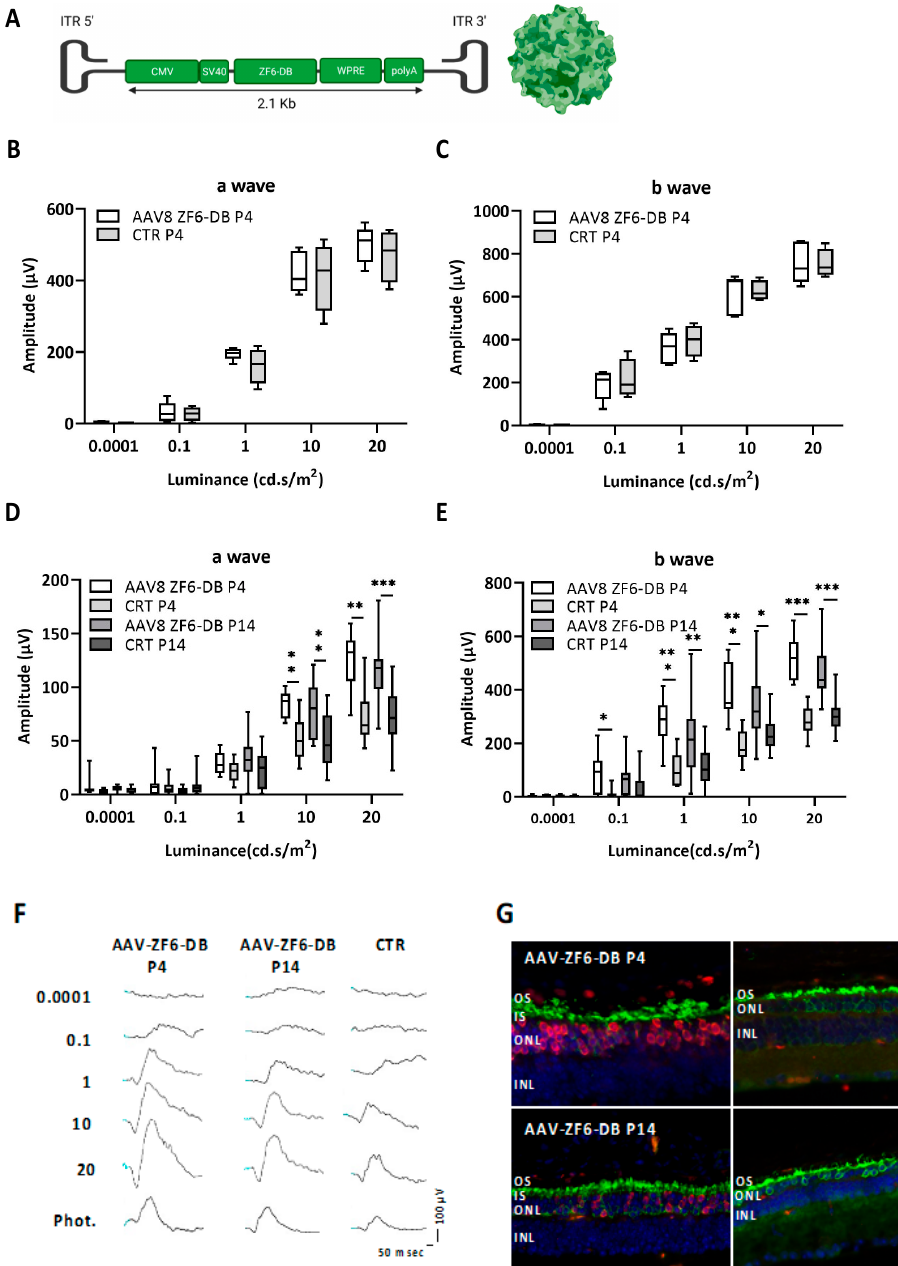
Figure 1. Early somatic delivery of ZF6-DB transcriptional repressor in the WT and P347S adRP murine model by adeno-associated virus (AAV) vector. ( A ) AAV8-CMV-ZF6-DB construct representation showing the cytomegaloviruses (CMV) promoter, including the SV40intron, the woodchuck hepatitis posttranscriptional regulatory element (WPRE), and the bovine growth hormone polyA (bGH). ( B , C ) a- and b-waves amplitudes recorded in scotopic conditions plotted as a function of light intensity (log cd * s/m 2 ) in one-month old WT animals treated at postnatal day 4 (P4, white box; n = 5; controls CTR grey box; n = 4). ( D , E ) a- and b-waves in one-month old P347S adRP mice treated with AAV8-CMV-ZF6-DB at postnatal day 4 (P4, white box; n = 9) and P14 (grey box; n = 18), compared with sham injected contralateral controls eyes (grey box; n = 9, P4 and n = 18, P14); Statistics: t -test corrected with Holm–Sidak method for multiple comparisons. * p ≤ 0.05, ** p ≤ 0.01, *** p ≤ 0.001. ( F ) Representative ERG track responses in scotopic and photopic conditions in one-month old P347S adRP mice treated with AAV8-CMV-ZF6-DB at postnatal day 4 and P14 compared with sham injected contralateral controls eyes. ( G ) Representative cryo-retinal sections co-immunostained with Rhodopsin (green) and ZF6-DB HA-tag (red) antibodies in one month old P347S mice treated at P4 and P14 and contralateral controls, sections were counterstained with Vectashield to visualize nuclei. OS, Outer Segment. IS, Inner Segment. ONL, Outer nuclear Layer. INL, Inner Nuclear